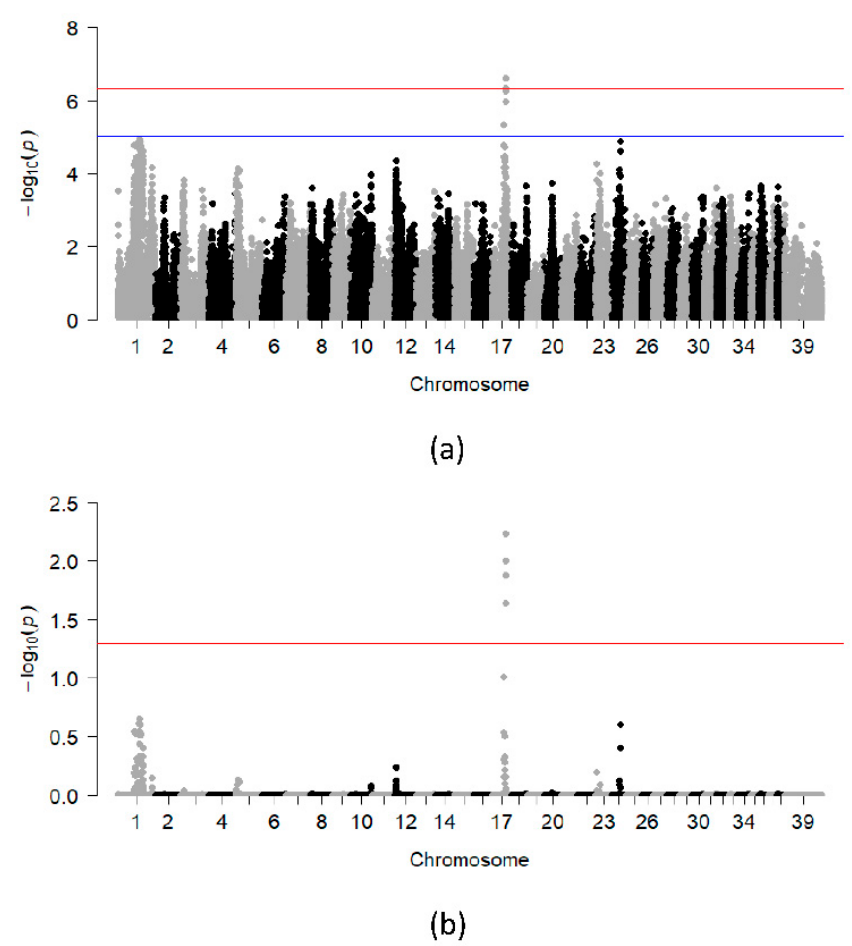
Figure 2. Chi-square based allelic association ( a ) and association test after 100,000 permutations ( b ) for the subset of unrelated dogs carrying DLA class II risk haplotypes for SLO. The blue and red lines indicate suggestive ( − log10[ p -value] ≥ 5) and Bonferroni-adjusted genome-wide significance threshold ( − log10[ p -value] ≥ 6.3), respectively.